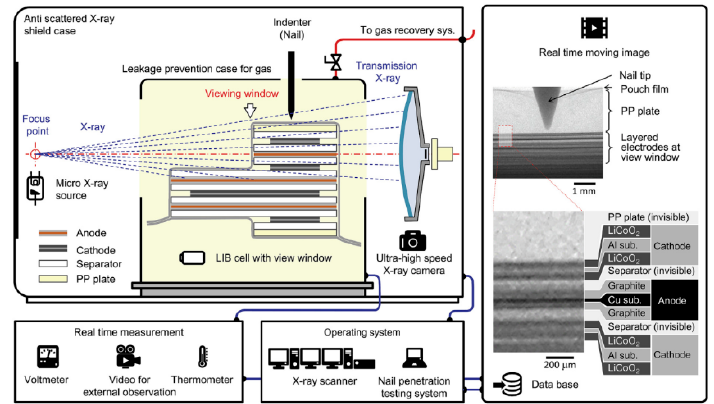
Figure 3. Schematic illustration of nail penetration system with internal short circuit (ISC) and x-ray scanners for laminated lithium ion batteries. Image on the right is an atypical x-ray transmission image of a laminated LIB cell recorded through the viewing window [52].